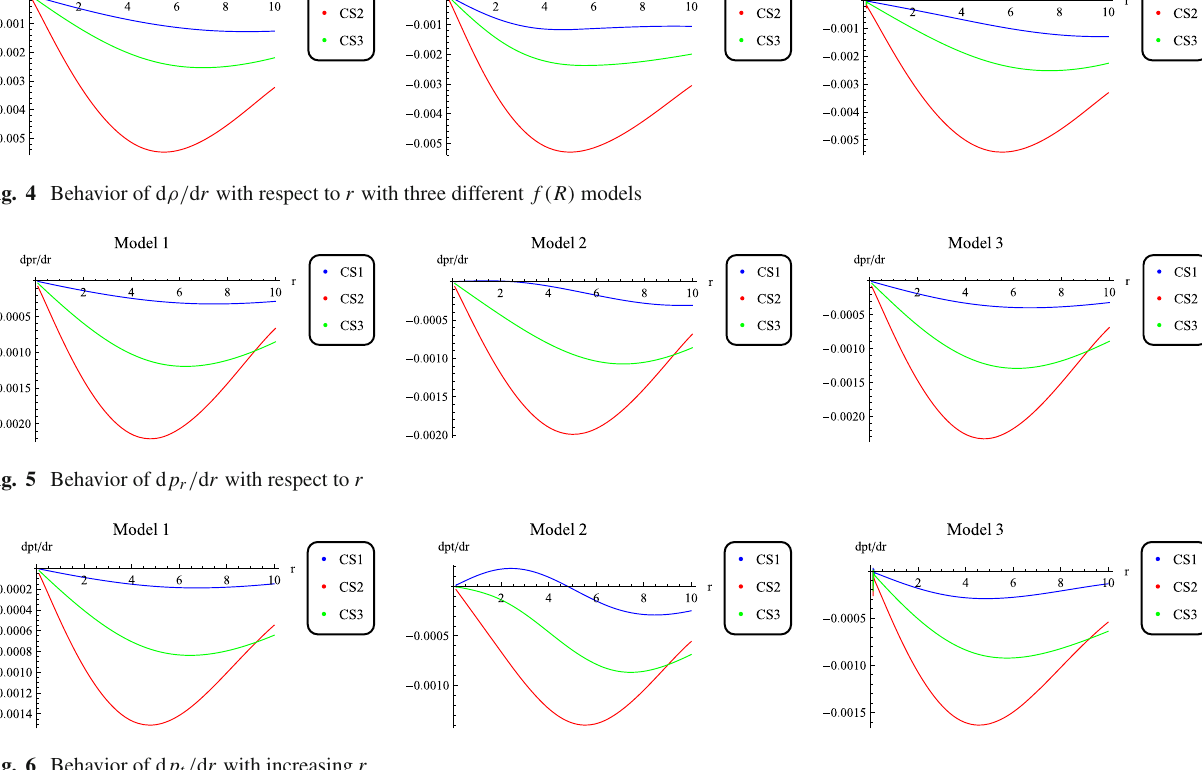
Fig. 6 Behavior of d p t / d r with increasing r